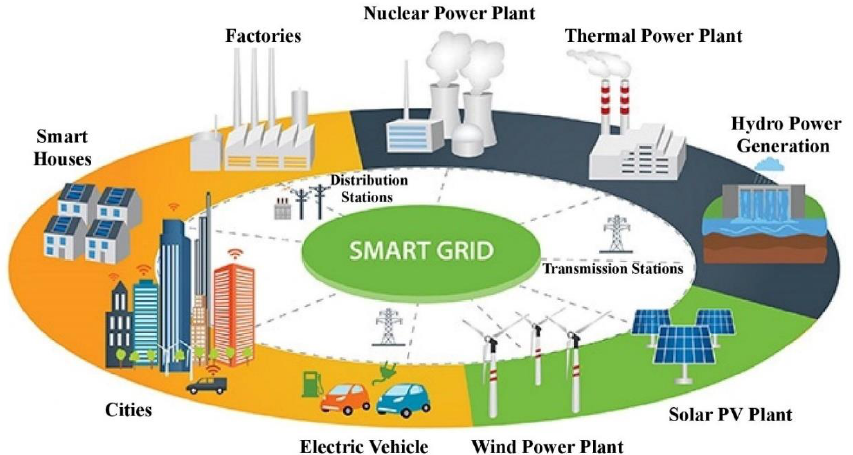
Figure 3. A schematic view of the smart grid showing a few of the dispatchable and non-dispatchable distributed generation technologies. Redrawn from Reference [53], 2018 eolas magazine.